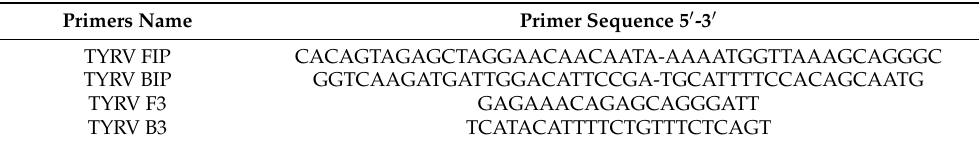
Table 2. Primers used in RT-LAMP reaction.